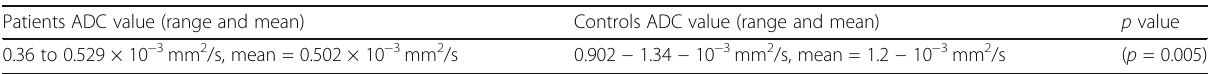
Table 2 The ADC value calculated in the patients versus controls Patients ADC value (range and mean) Controls ADC value (range and mean)